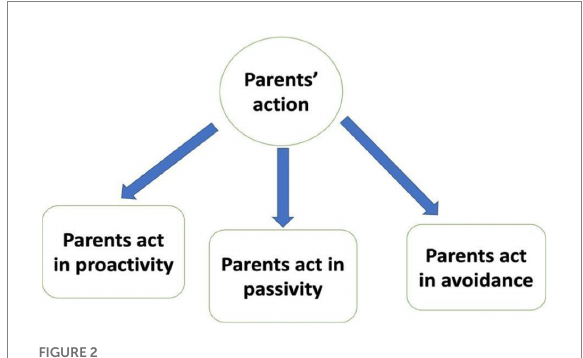
FIGURE 2 Change and human actions (adopted from Fung,